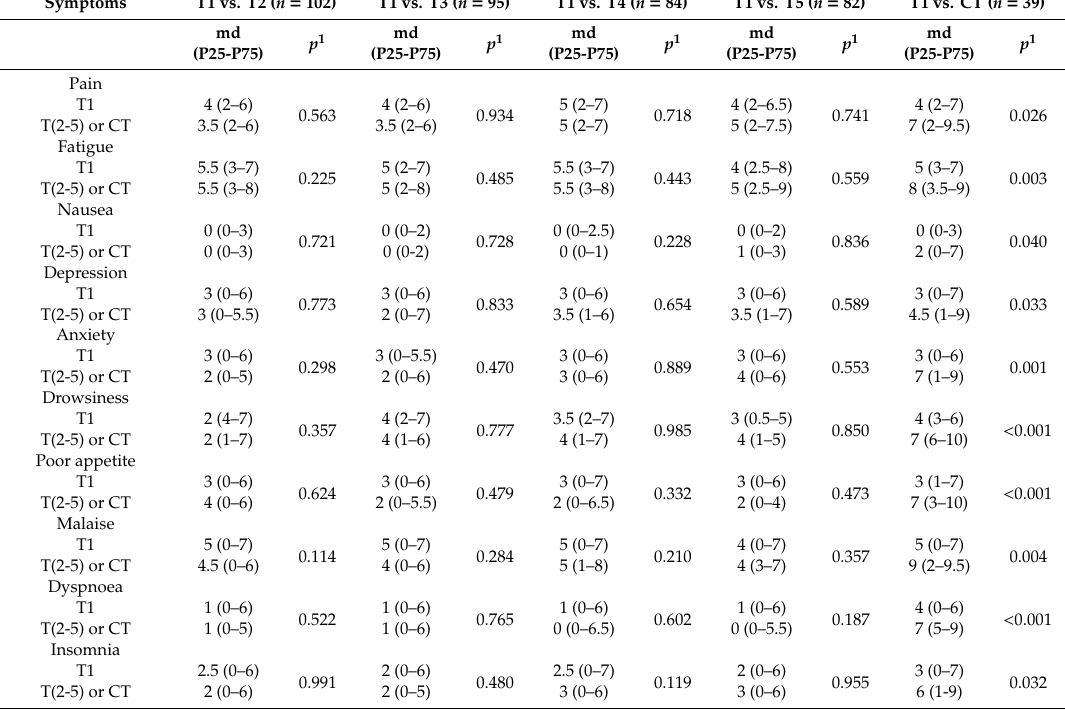
Table 2. Month-by-month comparison of symptoms using Edmonton Symptom Assessment System (ESAS) for residents in nursing homes.